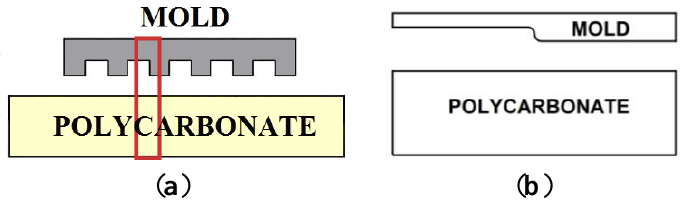
Figure 3. Cross-sectional shape of ( a ) the mold and substrate, and ( b ) the analyzed section.